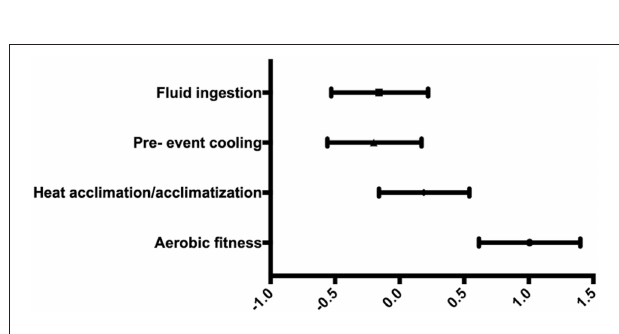
FIGURE 4 | Forest plot of Hedge’s g weighted averages of heat mitigation strategies on